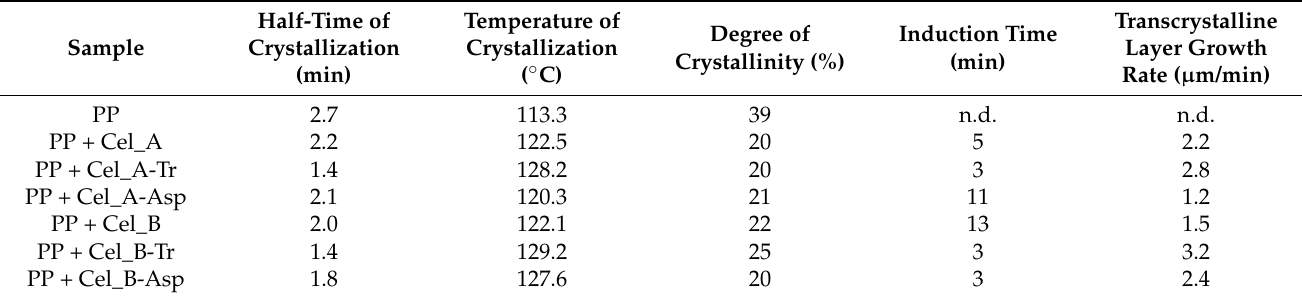
Figure 8. The crystal conversion of composites with PP matrix and unmodified and modified cellulose Cel_A ( A ) and unmodified and modified cellulose Cel_B ( B ). Table 6. The results of the differential scanning calorimetry and the polarizing interference microscopy for materials with PP matrix and cellulose fillers (n.d.—not